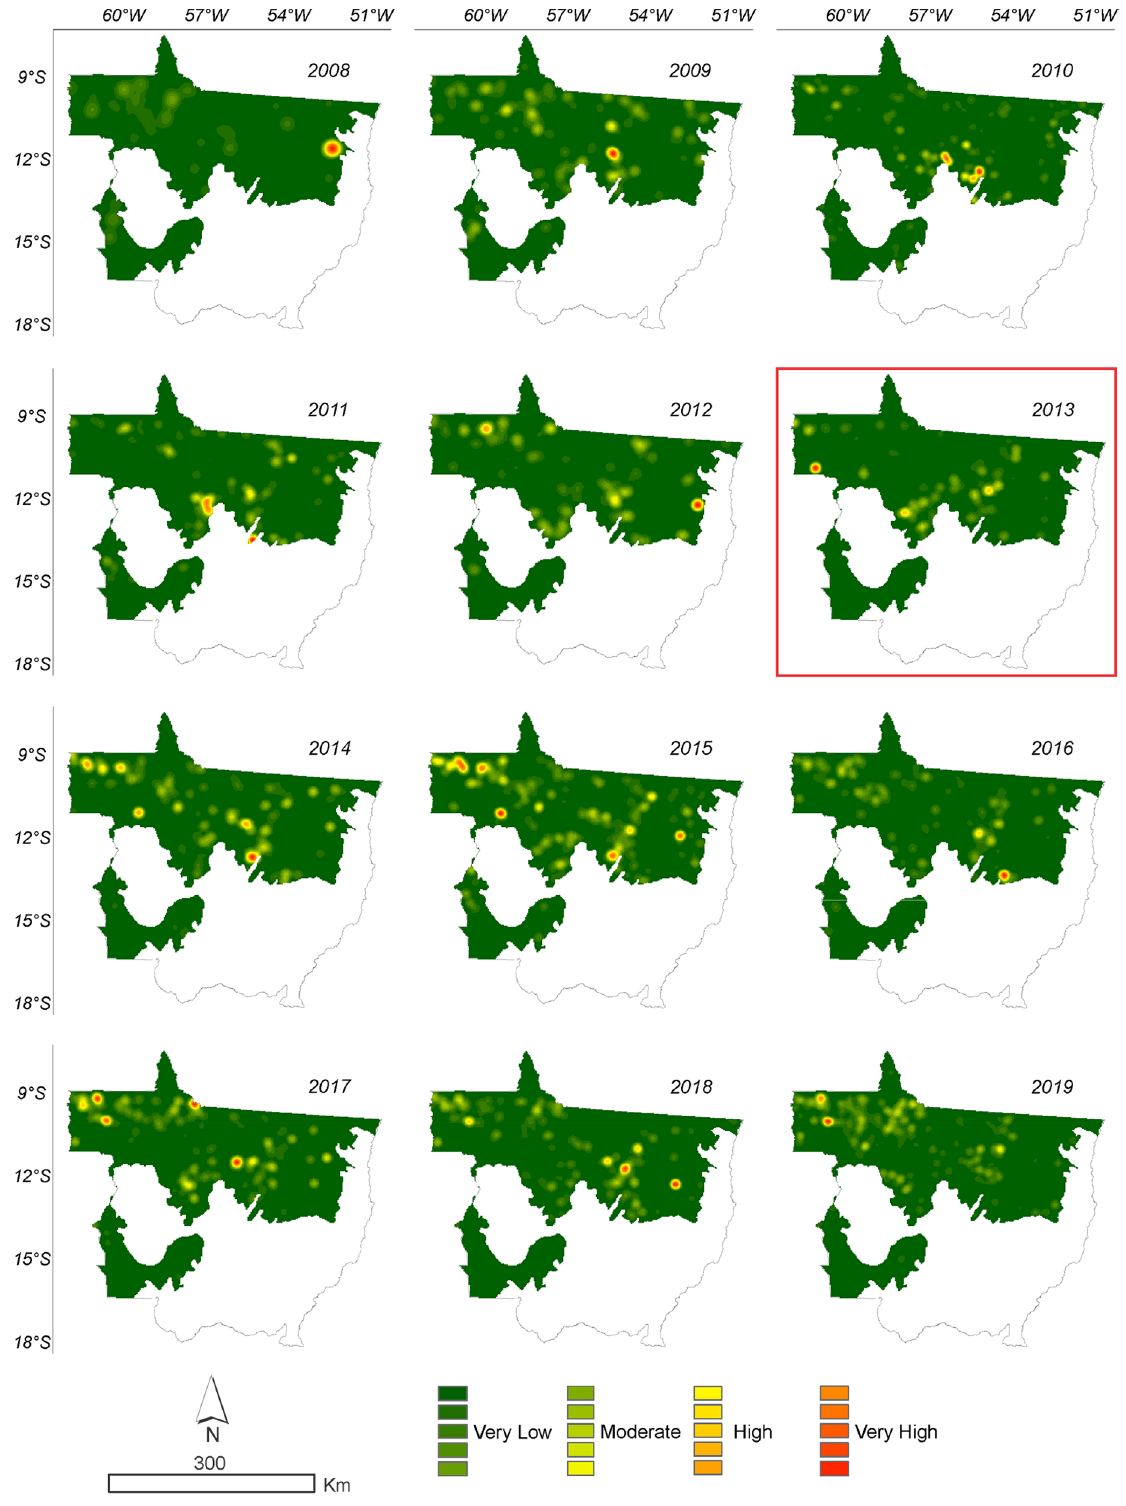
Figure 11. Annual deforestation density in the Amazonia biome in the State of Mato Grosso from 2008 to 2019 with data from ImazonGeo. The year highlighted by the red square corresponds to the likely change point in the time series identified by the Pettitt test (Table